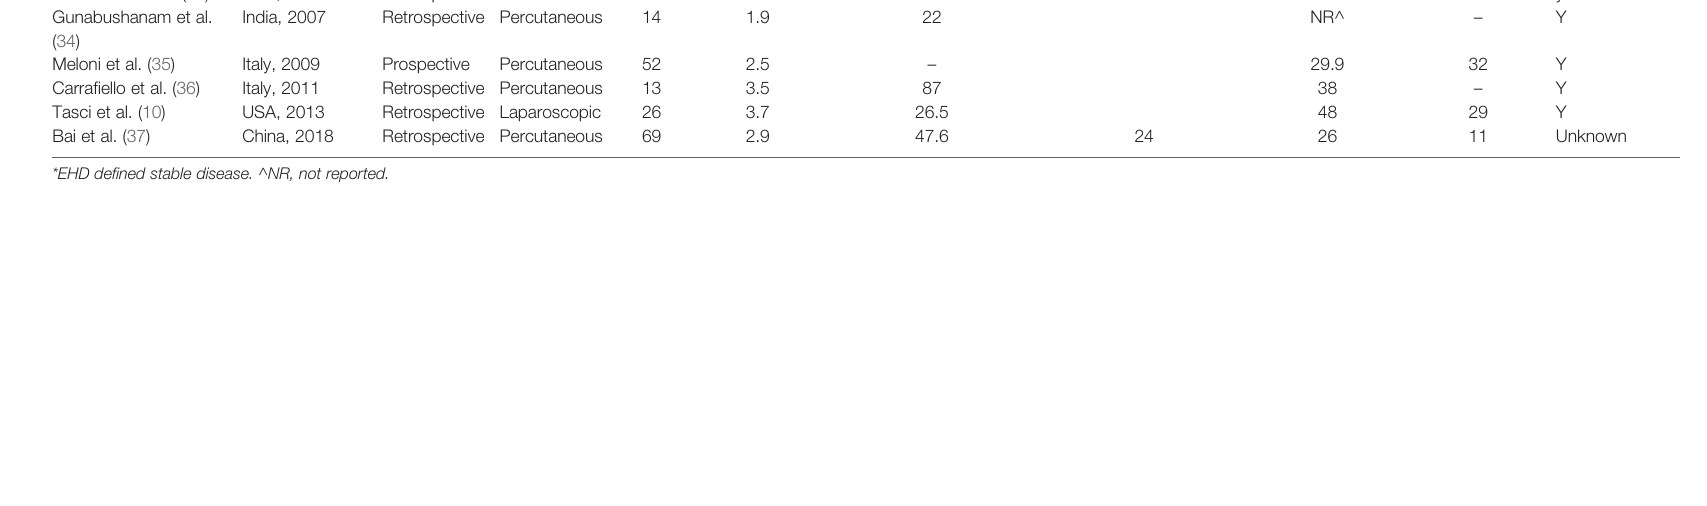
TABLE 4 | Transarterial Chemoembolization (TACE) and Transarterial Radioembolization (TARE). Study